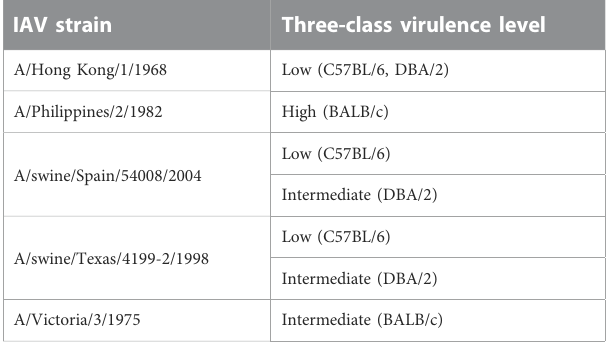
TABLE 7 H3N2 strains with alpha-catenin/vinculin-like domain assigned to M1 gene